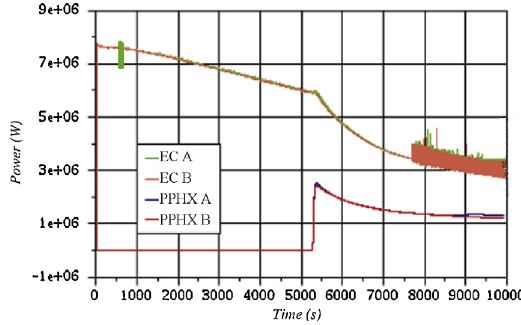
Fig. 11. Emergency heat removal by ECs and PPHXs